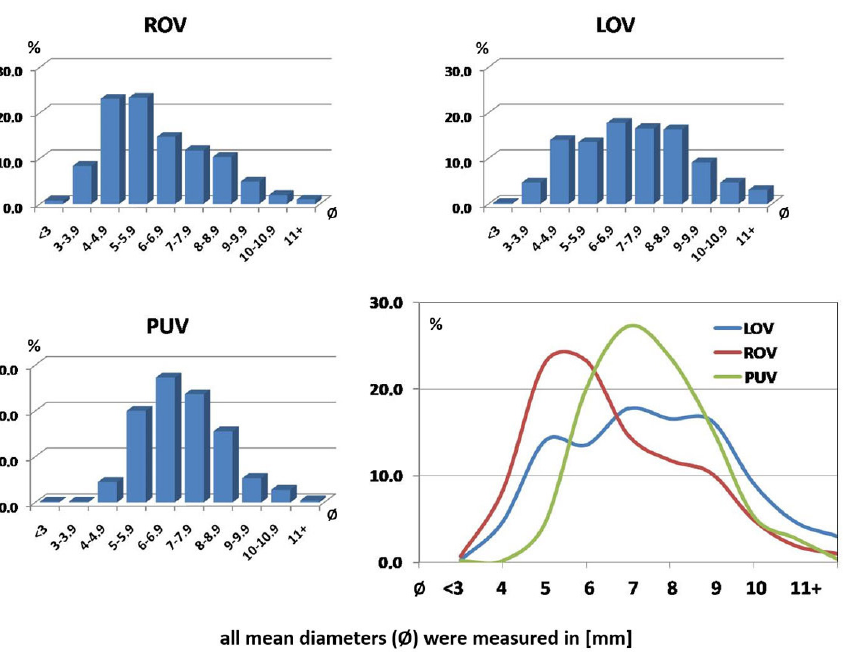
Figure 2. Main numerical-parametric relationships resulting from the analysis of 535 patients from our database, carried out in 2017–2019.